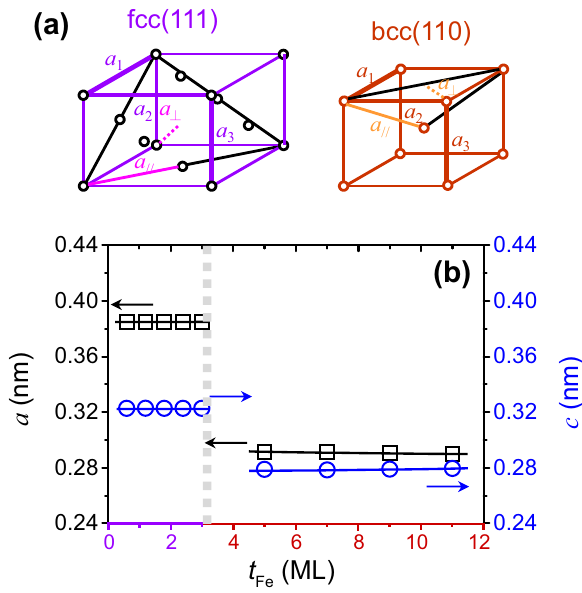
Figure 3. ( a ) Schematic diagrams of fcc(111) and bcc(110). ( b ) The lattice parameters a and c for fcc(111) and bcc(110) versus Fe thickness, by converting the experimental data for both interlayer distance a lattice parameters a // to the lattice parameters a and c